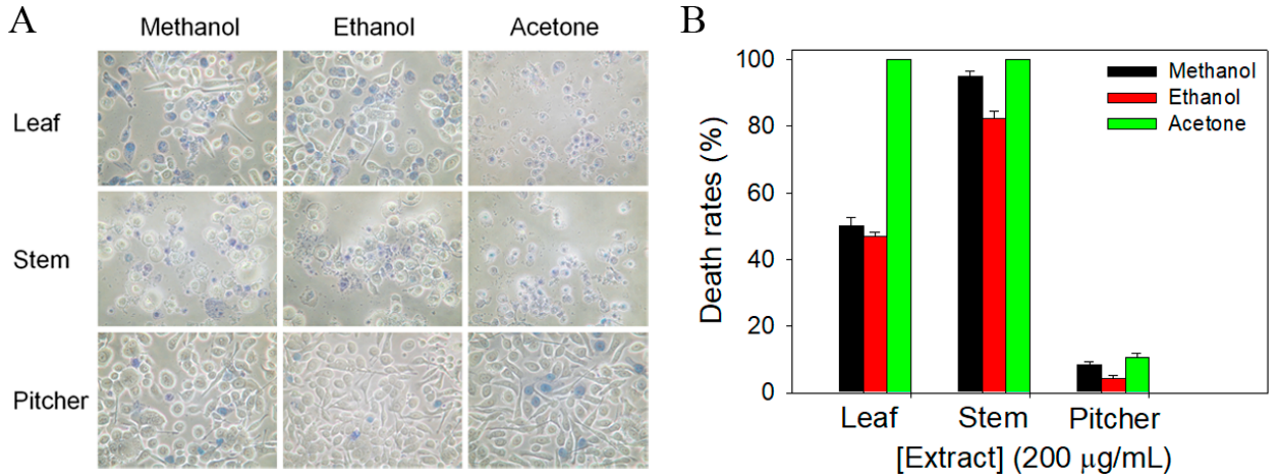
Figure 2. The cytotoxic effects of different N. miranda extracts against PC-9 cells. ( A ) Trypan blue dye exclusion staining. The cytotoxic effects of different N. miranda extracts against PC-9 cells were estimated with trypan blue assay after 24 h of incubation. The PC-9 cells incubated with N. miranda -stem-acetone and N. miranda -leaf-acetone of 200 μ g/mL were almost dead. ( B ) The death rates of PC-9 cells. The anti-PC-9 activity of N. miranda extracts followed the order: acetone > methanol > ethanol.